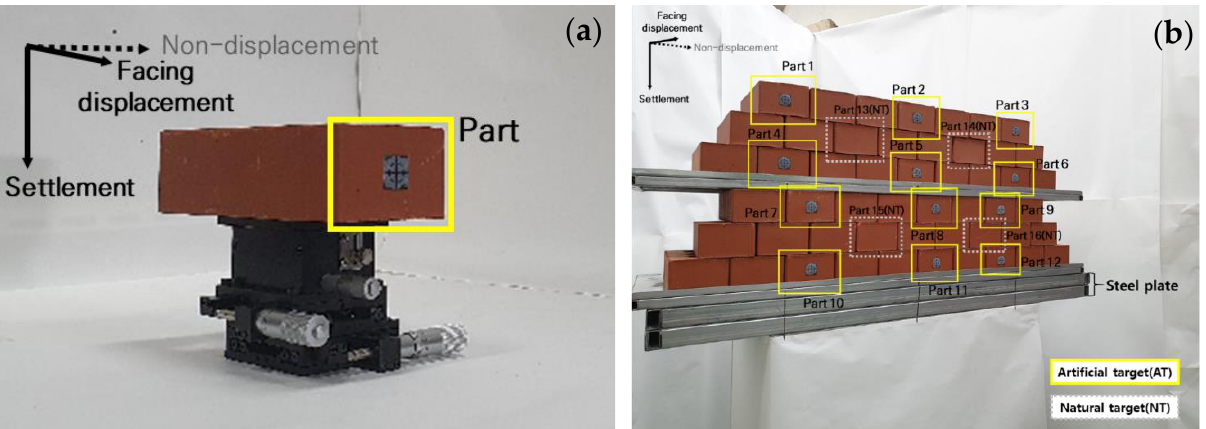
Figure 2. Experimental setups and target parts for single block and multiple blocks. ( a ) Single-block experiment on linear stage; ( b ) Multiblock experiment on steel plate .